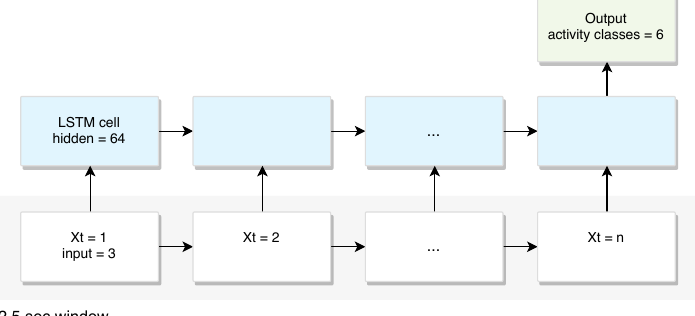
Figure 3. Many-to-one long short-term memory (LSTM) network architecture used for activity classification with six classes. n stands for the number of samples included in a 2.56 s